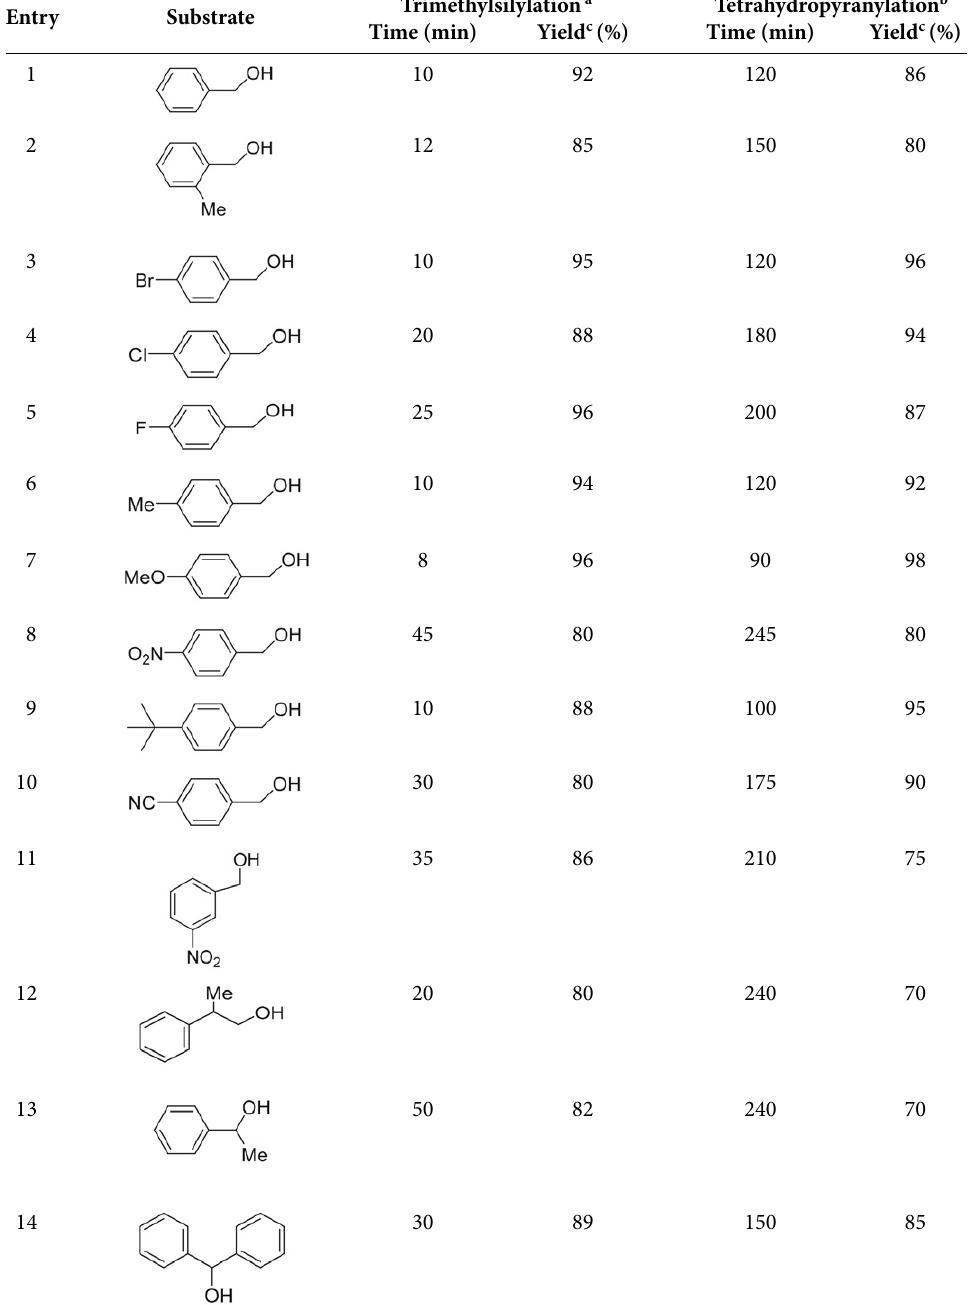
Table 5. Fe 3 O 4 @PyHBr 3 MNP-catalyzed trimethylsilylation and tetrahydropyranylation of